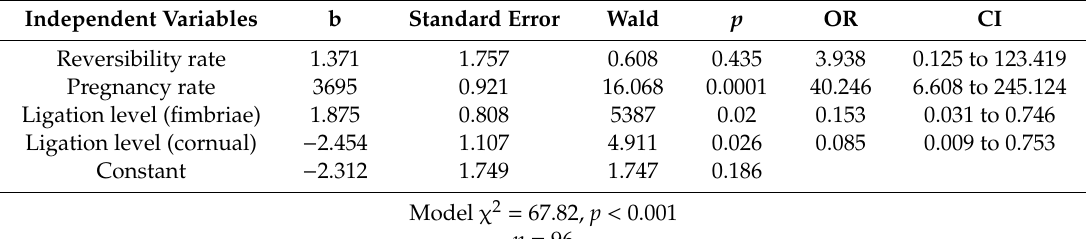
Table 6. Logistic regression with occurrence of birth as a dependent